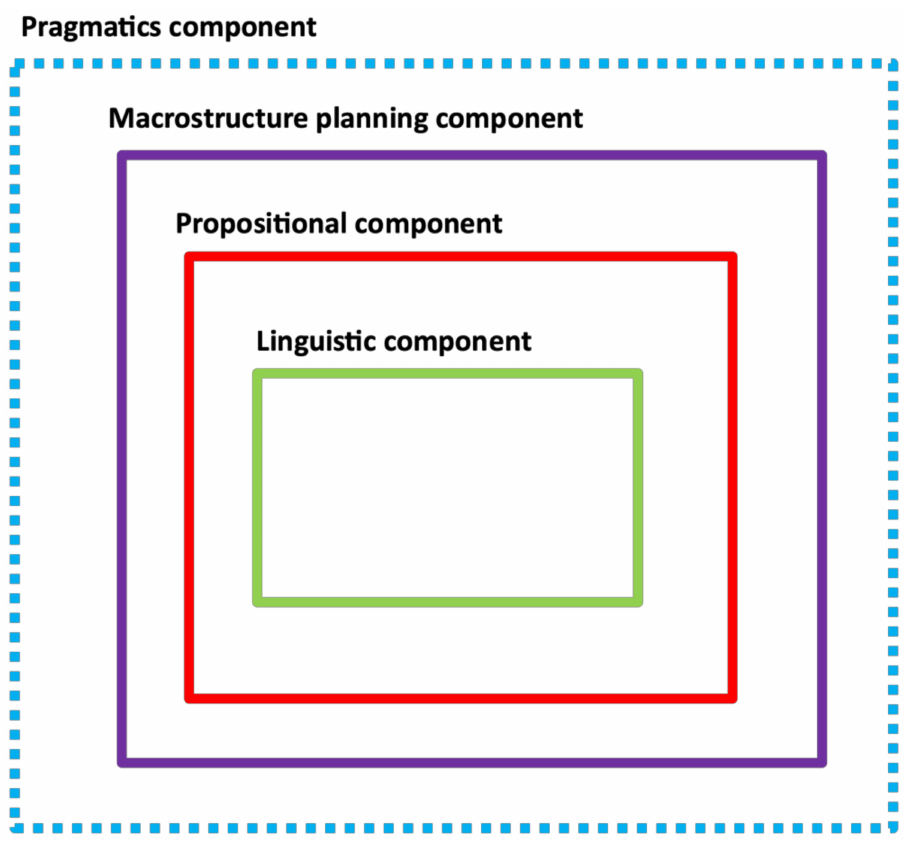
Figure 2. The LUNA framework for spoken discourse see Section 3.2. for information about each